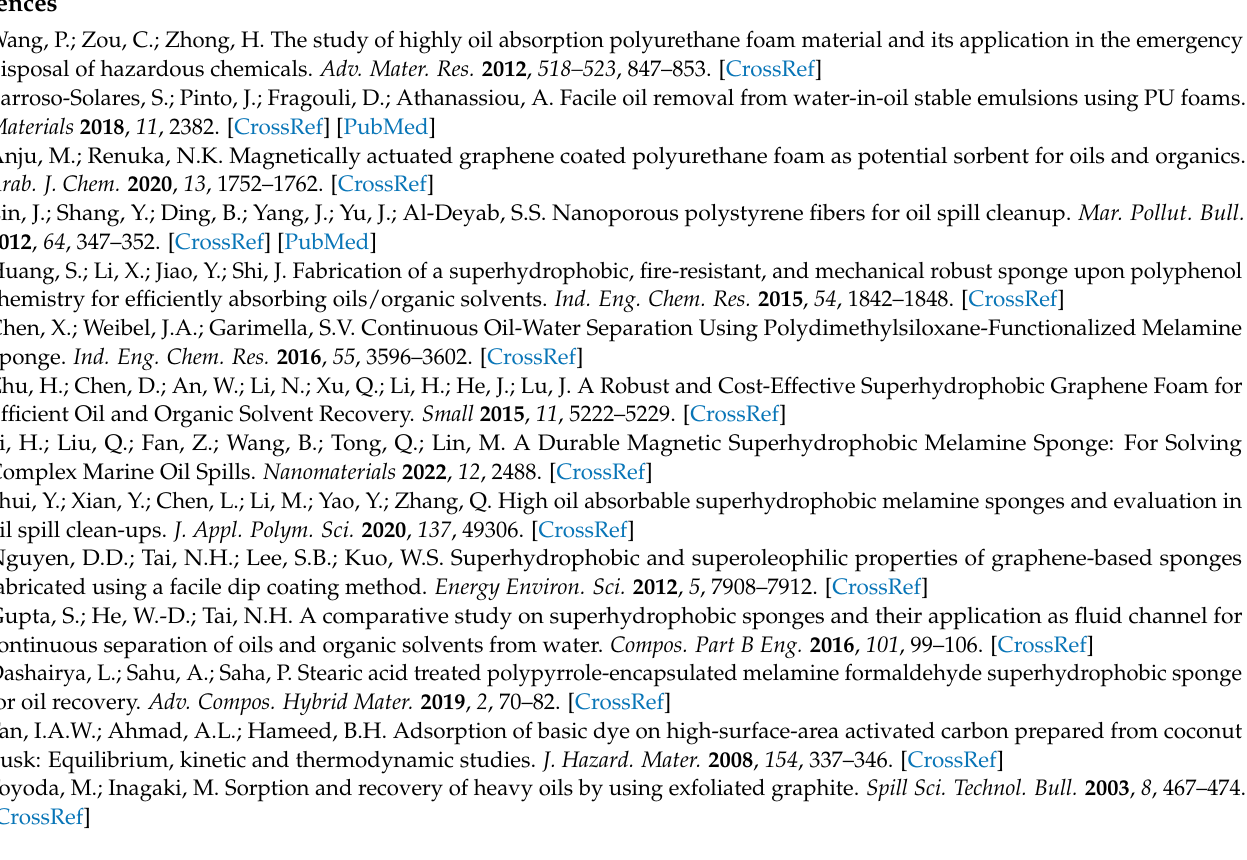
Absorption spectra of rGO-ascorb. Figure S4: Raman spectra of polyurethane-rGO composites. Table S2: Data obtained from Raman Spectra calculations. Figure S5: C1s XPS spectra of polyurethane- rGO composites. Table S3: Contents of different carbon species on the surface of polyurethane and polyurethane-based composites determined by